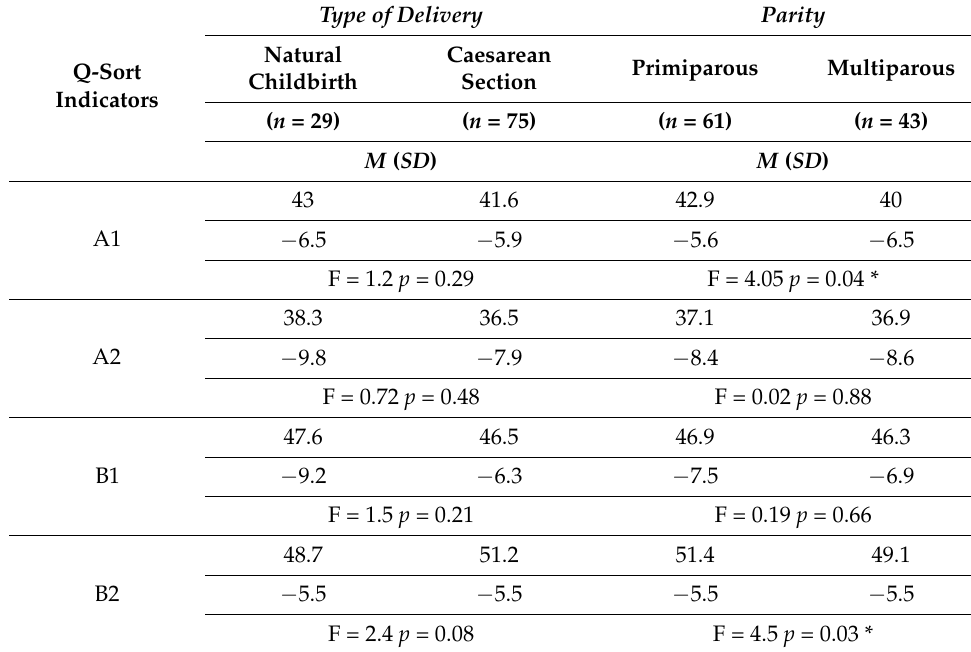
Table 6. Maternal competence (Q-sort scores) in NICU (T1) in relation to type of delivery and parity (MANOVA) ( n =